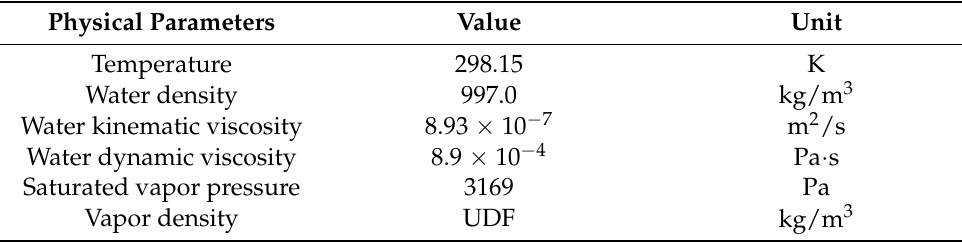
Table 1. Physical properties of the fluid.